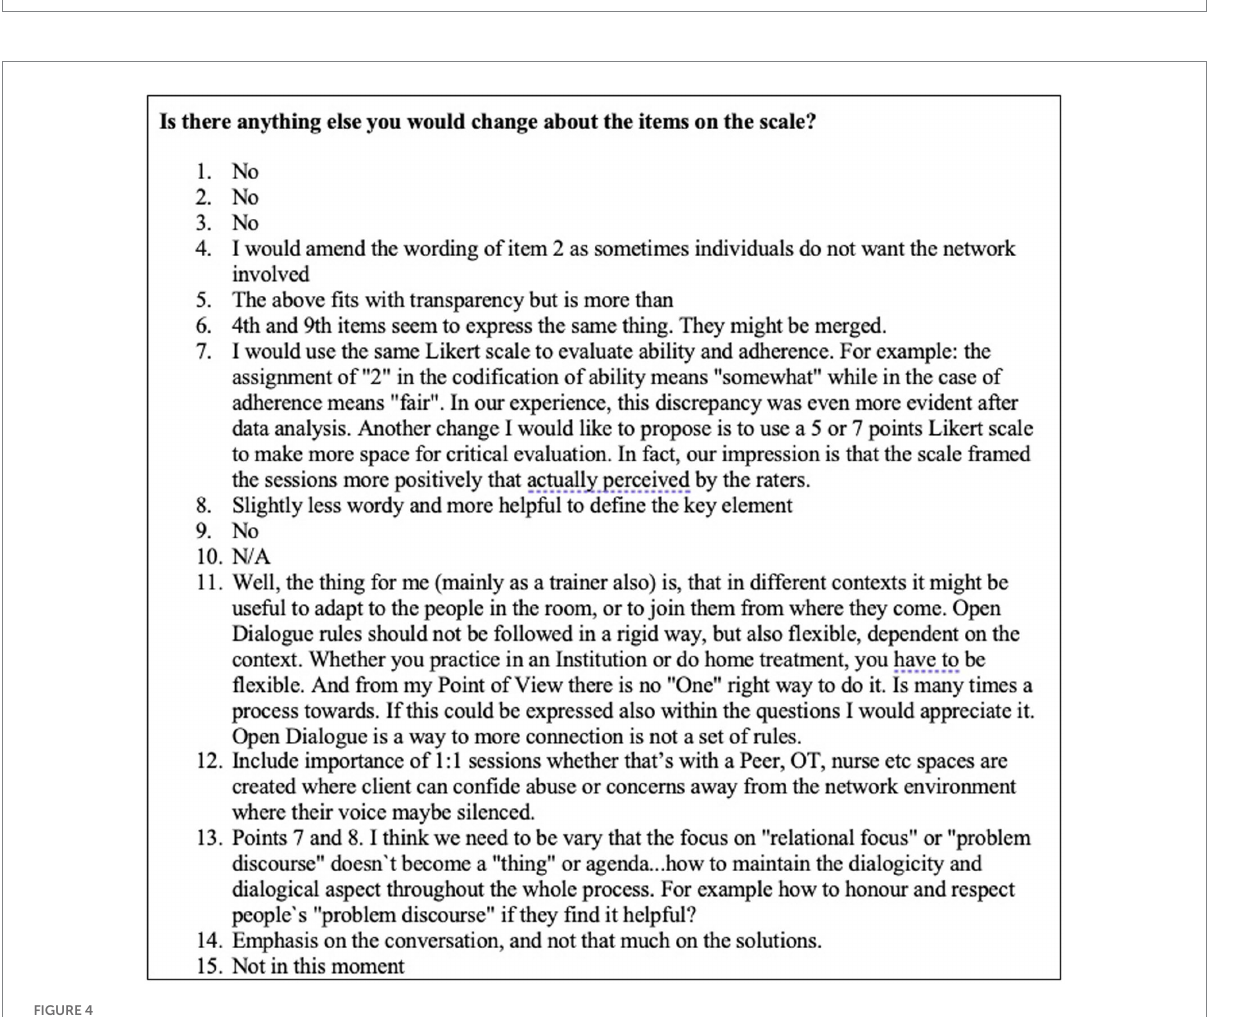
FIGURE 4 Changes to the